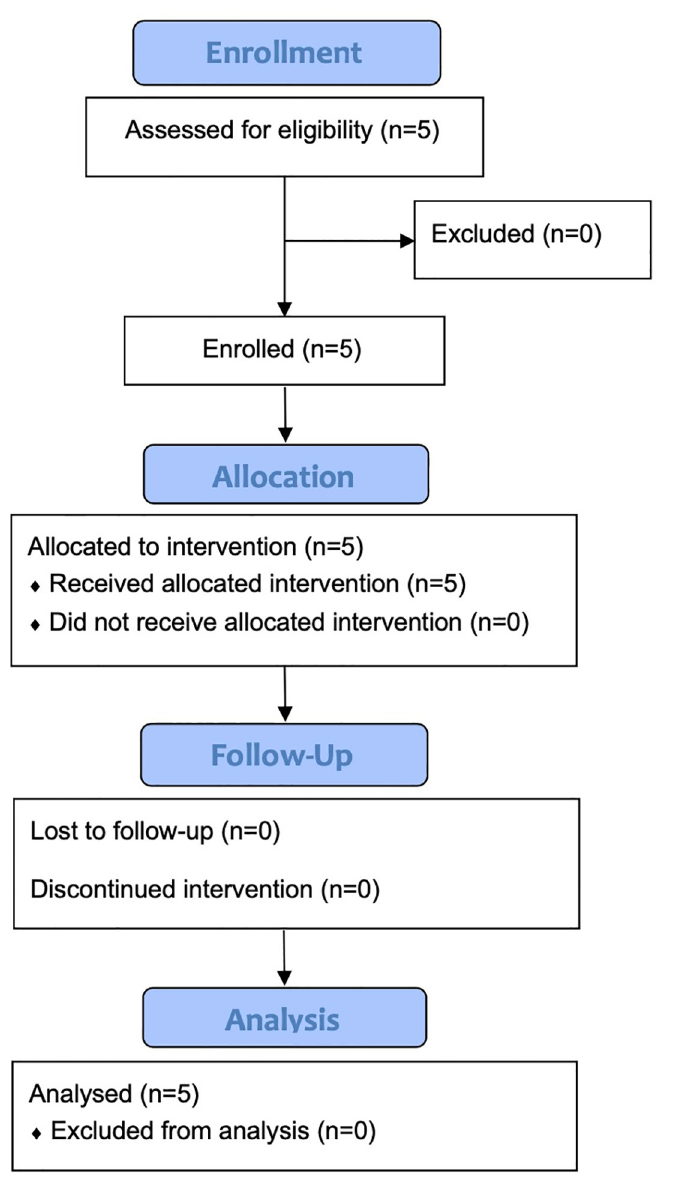
Fig 1. Study CONSORT